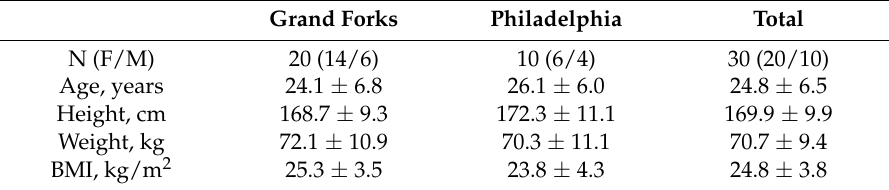
Table 1. Participant characteristics. BMI, body mass index.